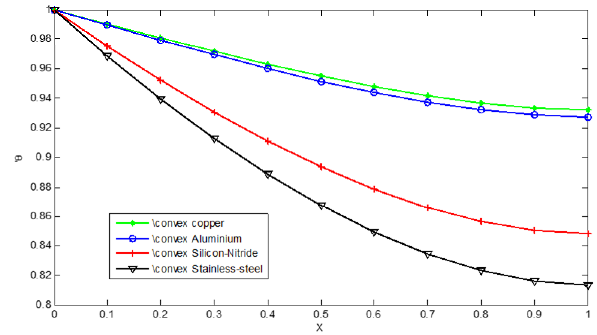
Figure 7. Effect of different materials on non-dimensional temperature distribution of fin with convex